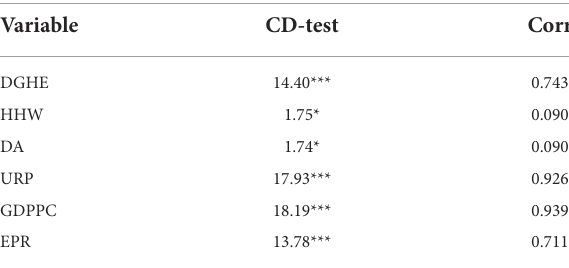
TABLE 3 Cross-section dependence